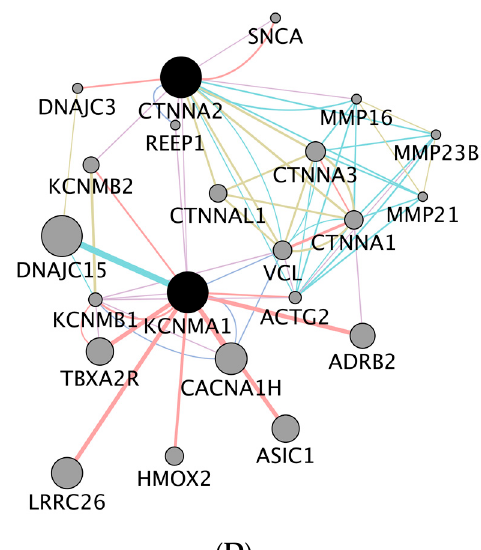
Figure 7. Gene networks constructed based on the candidate genes overlapping significant SNPs for the studied traits. ( A ) Genes associated with longevity; ( B ) GMNC interaction network; ( C ) genes associated with age at first calving; ( D ) genes associated with direct genetic effects for calf weight at four months. Circles represent network nodes connected by lines (edges). The size of the nodes depends on their level of connectivity in the network (as more edges result in a larger circle size). On the other hand, edges with thicker line weights correspond to gene-gene interactions with stronger support by the literature. Table 5. Pathway enrichment analysis for genes of the Longevity network. The table shows the 10 most relevant pathways sorted by p